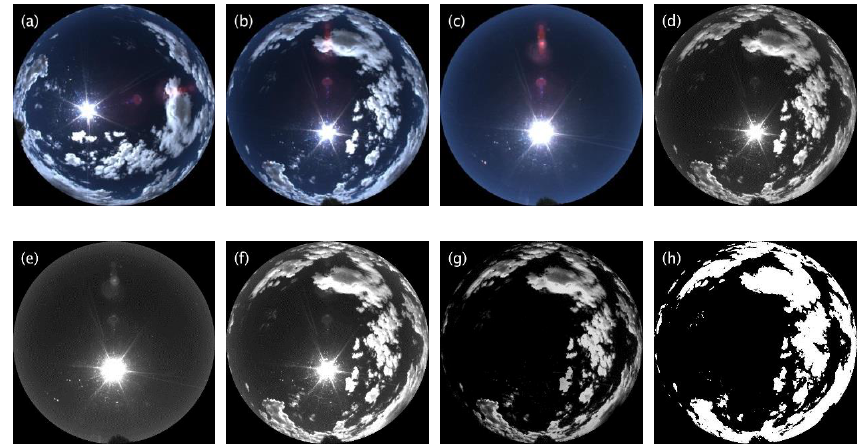
Figure 5. Cloud detection result based on CSB. Panel (a) is the original TCI image captured on 7 June 2013, (b) is the image after rotation, (c) is the real clear background image with the same solar elevation angle as (b) , (d) shows the green channel of (b) , (e) shows the green channel of (c) , (f) represents the new green channel of (d) after brightness adjustment, which has very similar brightness distribution to (e) especially for sky background, (g) is the difference of (f) and (e) , and (h) is the ultimate cloud detection